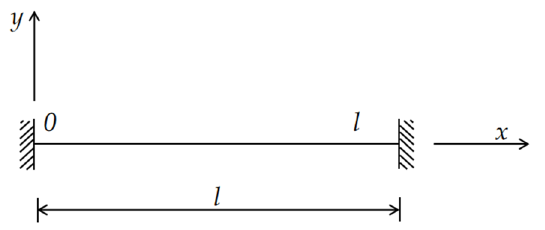
Figure 3. Cable with both ends fixed.